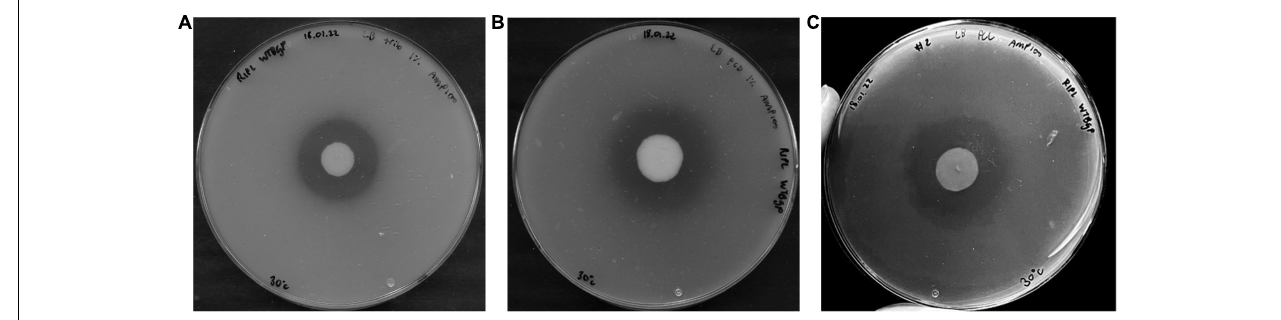
FIGURE 5 | Heterologous expression by BL21 RIPL-(pET20b:BgP) clone plated on; (A) 1% tributyrin, (B) 1% PCD, and (C) 0.1% PCL, each prepared using LB agar and incubated for 6 days at 30 ◦